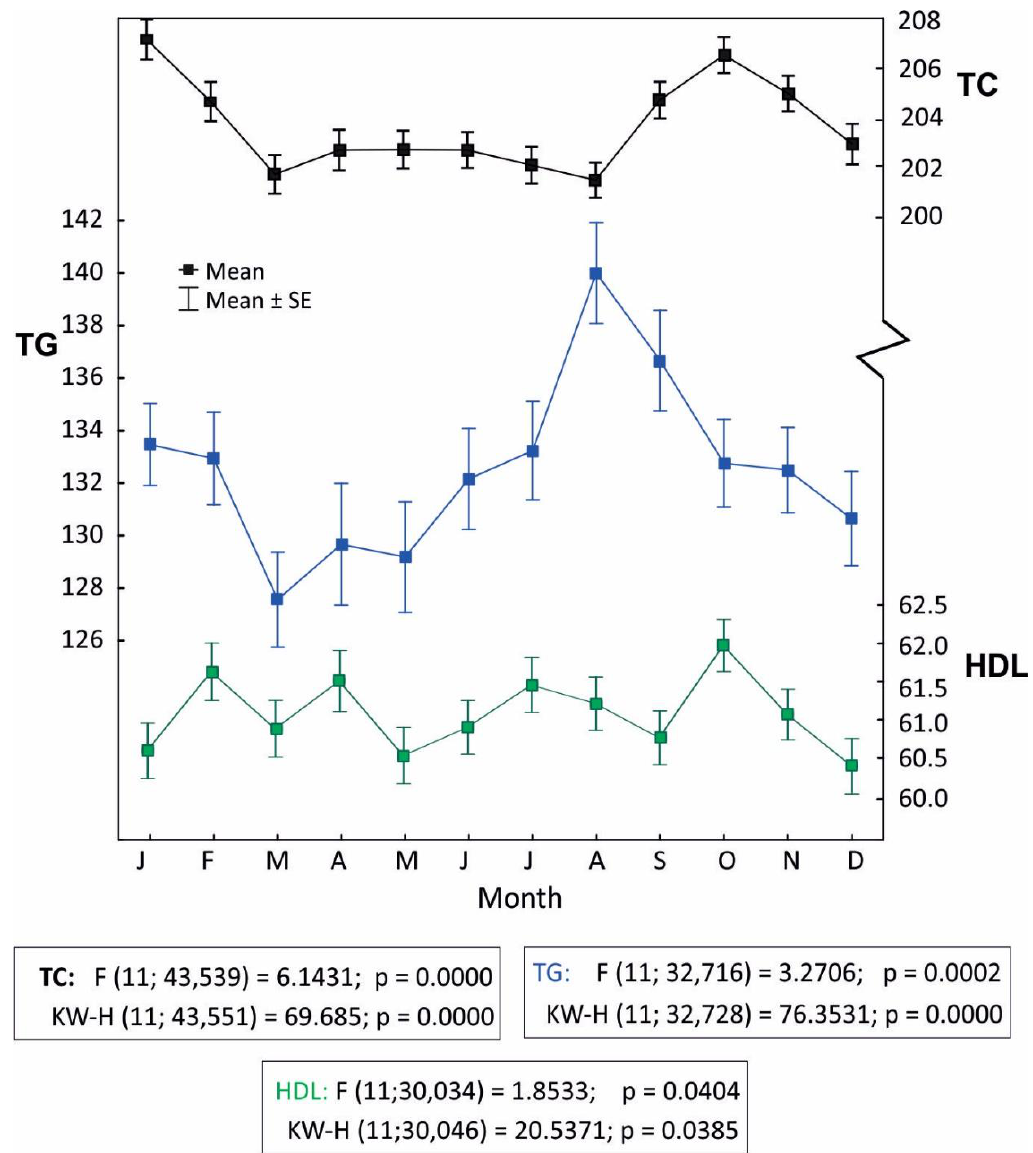
Figure 1. Monthly variations of lipid parameters (LP) levels. Data analysis was performed by one-way analysis of variance (ANOVA) (F-test) and Kruskall–Wallis (KW-H) test.